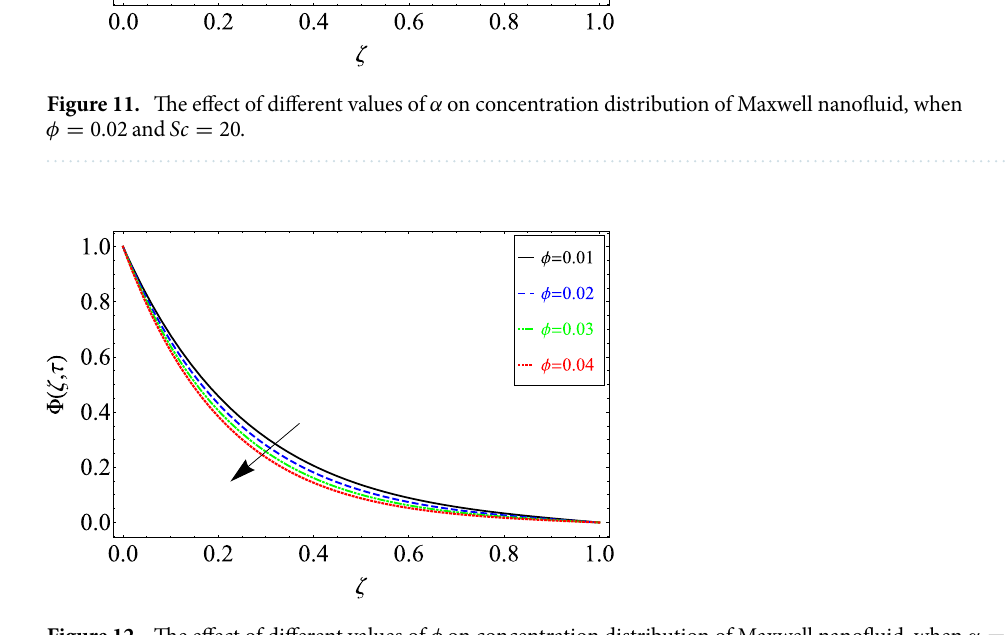
Figure 12. The effect of different values of φ on concentration distribution of Maxwell nanofluid, when α = 0.7 and Sc = 20